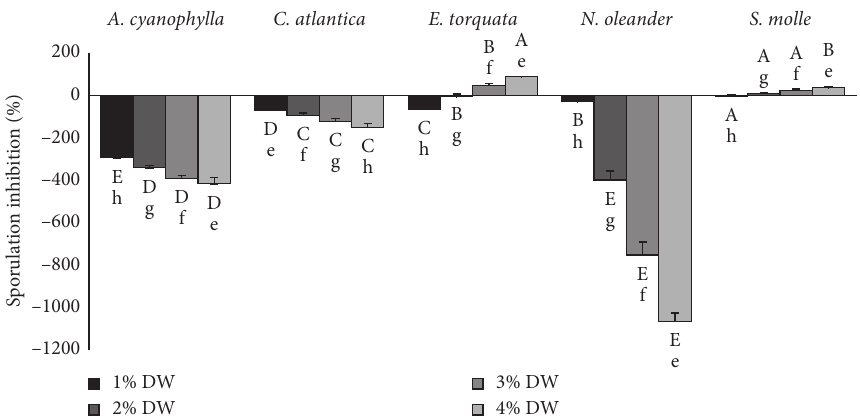
Figure 3: Effect of different percentages of plant DW on M. scaettae sporulation. Plant species and extract concentration had significant effects on the percentage of sporulation inhibition (one-way ANOVA, p < 0 . 05). Each bar represents the mean of four replicate plates per concentration. Within each plant species, bars followed by the same lowercase letters indicate no significant differences among extract concentrations, while within each concentration, bars followed by the same uppercase letters indicate no significant differences among plant species (Bonferroni tests, p < 0 . 05). Error bars represent standard errors.